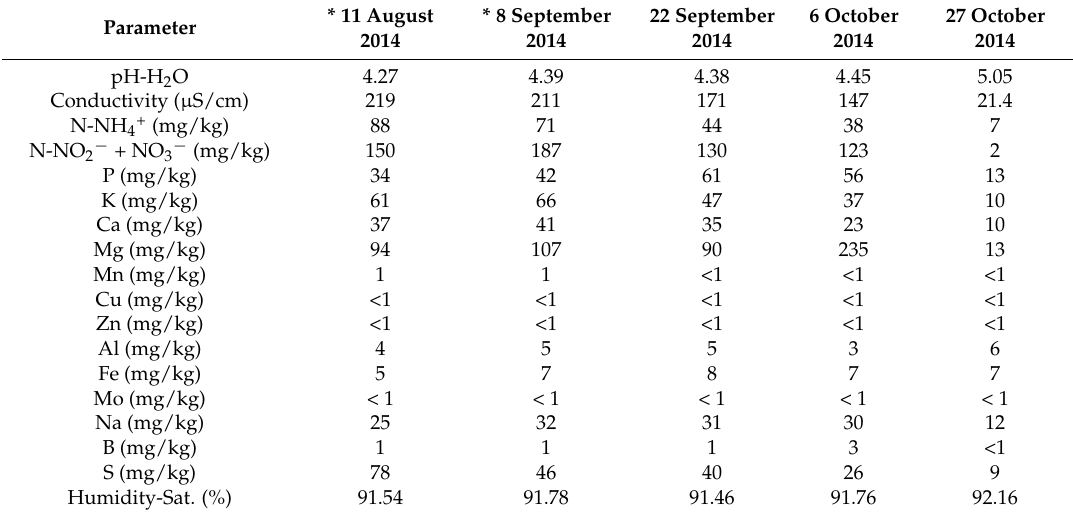
Table 2. Physicochemical parameters about sampled growth medium identified by sampling period. The data were obtained under analysis at an ISO-17025 certified laboratory. * Those samples were kept refrigerated below 0 ˝